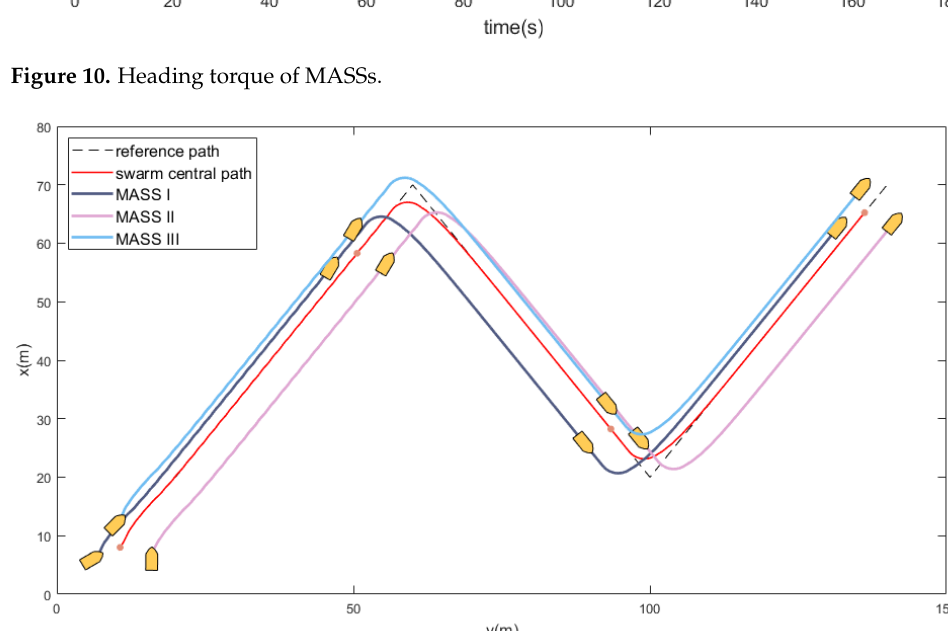
Figure 11. Reference path and path of MASSs (no arc LOS).